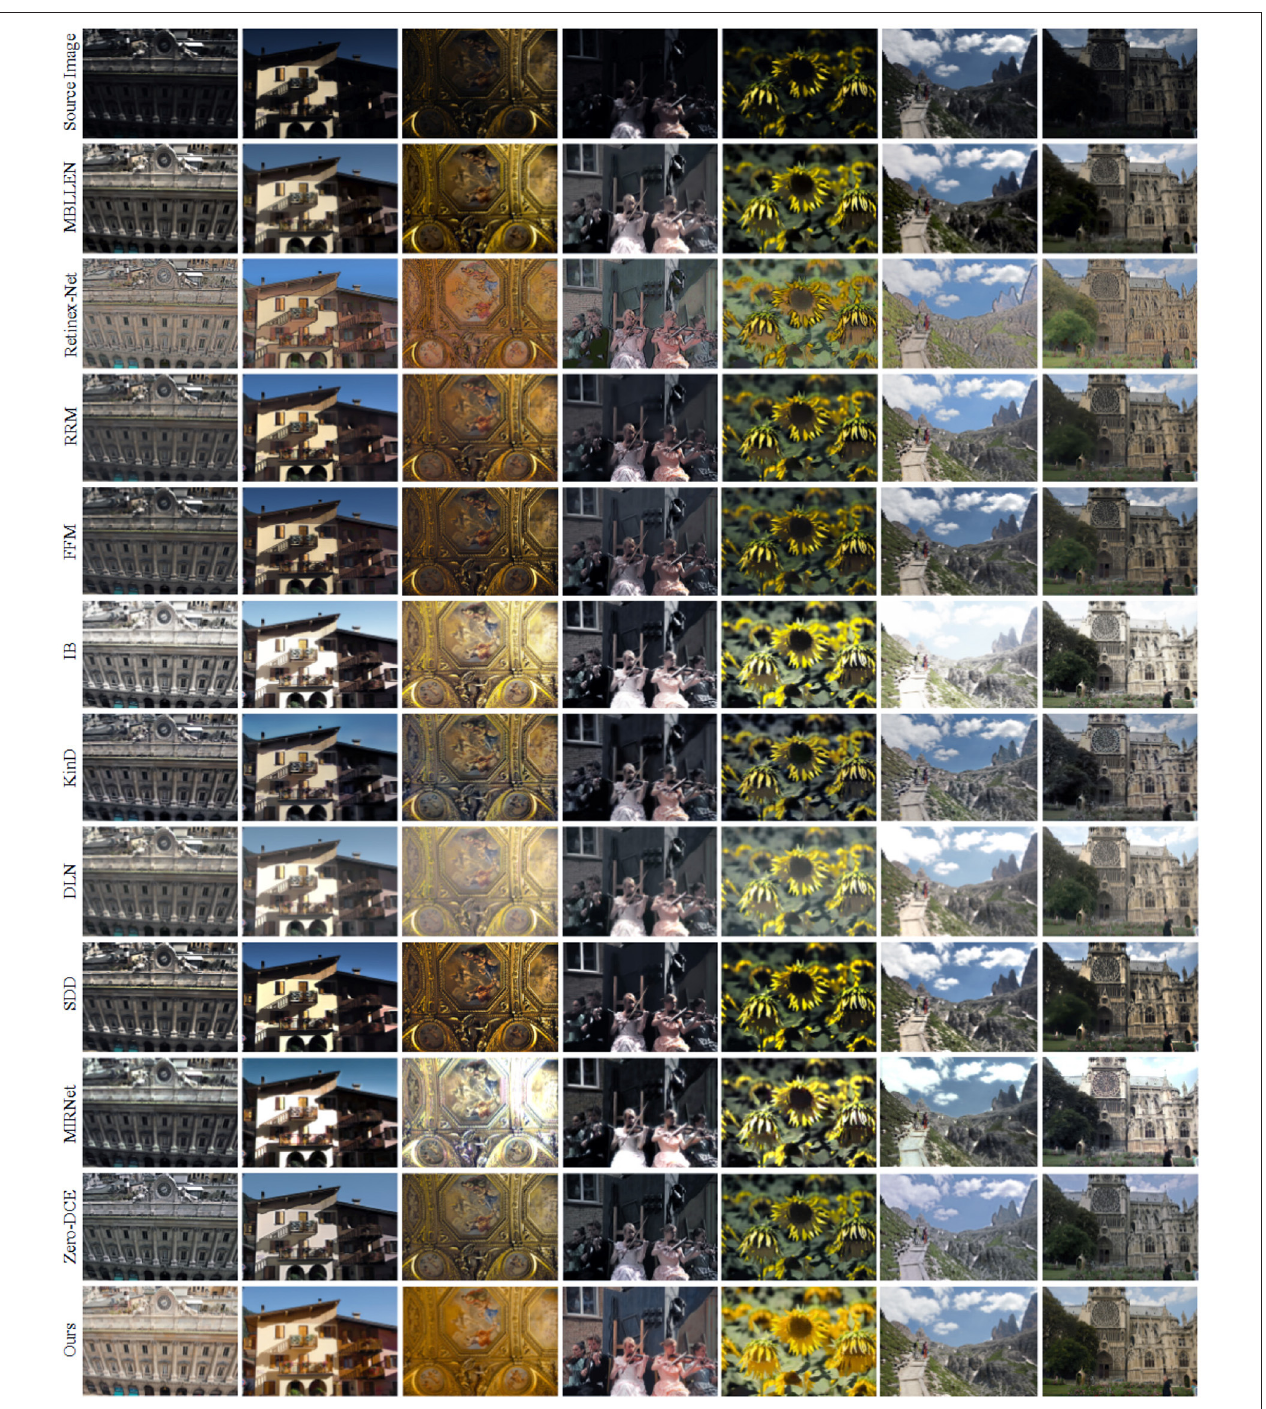
FIGURE 6 | Enhancement results of different low-light enhancement methods in real low-light images. The last row is the enhancement result of our method.